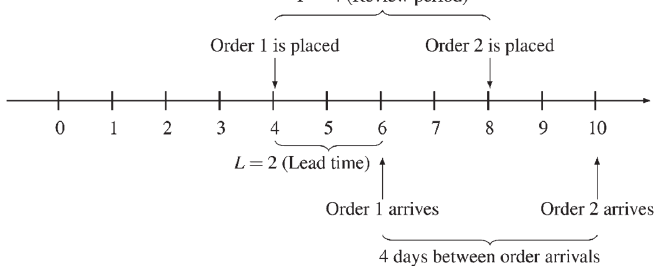
Fig. 1. Illustration of two successive order arrivals under deterministic lead time.